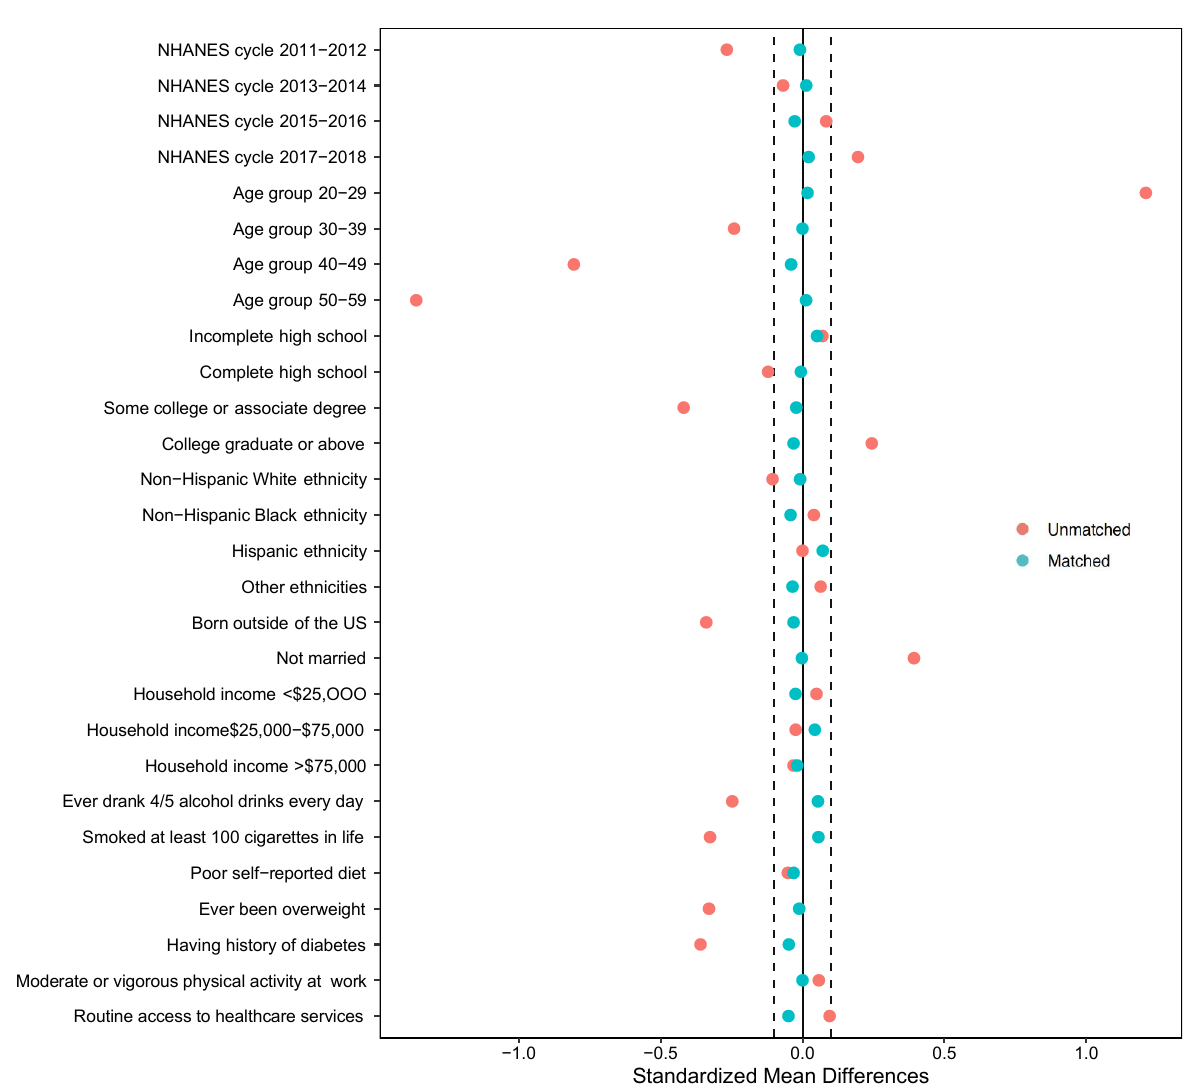
Figure 4. The covariate balance in the unmatched (complete case data) and matched datasets from a study investigating the association of human papillomavirus vaccination history with HPV-related cancers among U.S. adults aged 20–59 years in the National Health and Nutrition Examination Survey (NHANES), 2011–2018. Standardized mean differences for the unmatched dataset ( n = 9891) are shown in red dots. Standardized mean differences for the matched dataset ( n = 1782) are shown in blue dots.